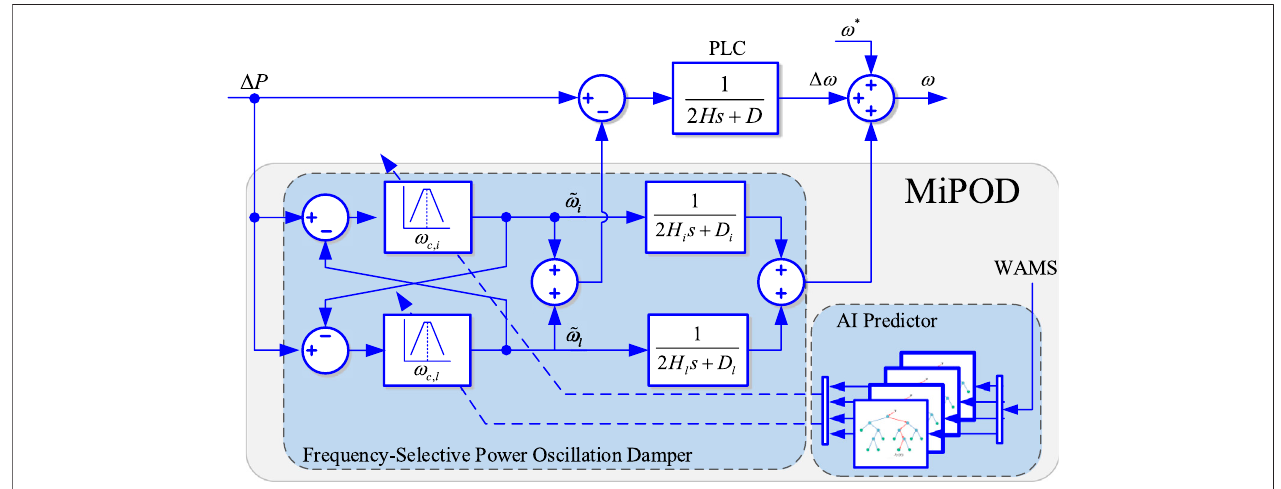
FIGURE 3 | Control block diagram of the